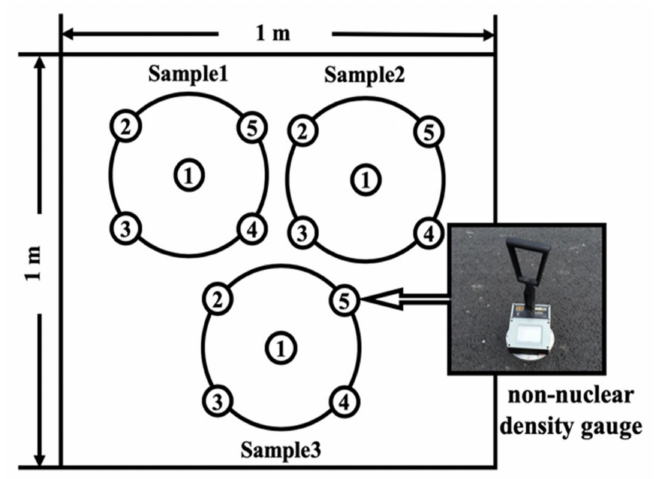
Figure 4. Schematic of density calibration in the field